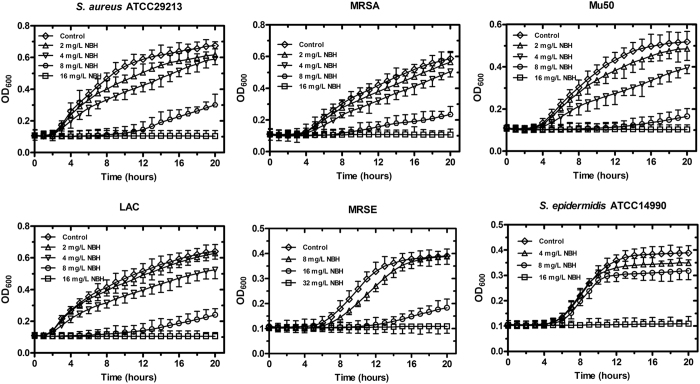
Concentration-dependent inhibition of NBH on the growth of four S. aureus and two S. epidermidis strains.NBH was added to cell cultures containing different tested strains to final concentrations of 2, 4, 8, 16 or 32 mg/L, with addition of an equal volume of sterile water as the controls. The growth curves for six tested strains were measured using a BioscreenC™ instrument in the absence and presence of different concentrations of NBH. Sample frequency was 1 h, and data at specified time points are represented as mean ± SD for three replicates.